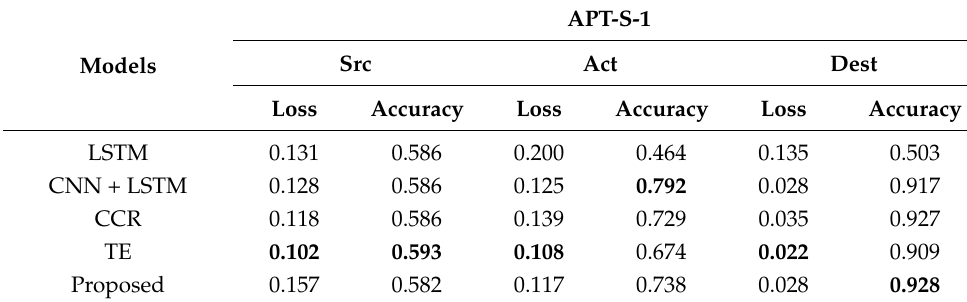
Table 5. Performance based on APT-S-1 and neighborhood graph.